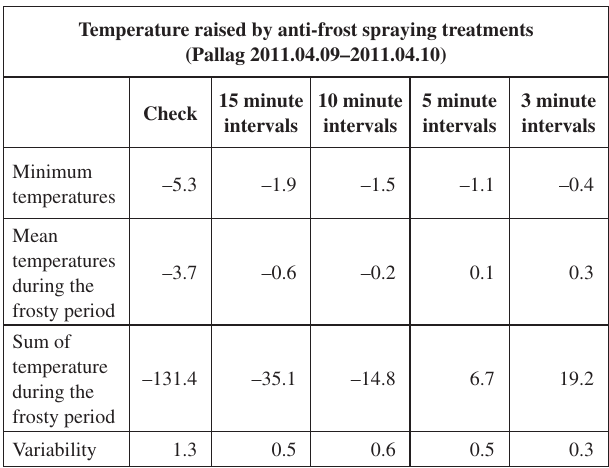
-10,0-5,00,05,010,015,020,0 Figure 8 – Temperatures as changing in the spraying experiment with 5 minute intervals (blue) related to the check area (red) in the plum plantation at Pallag between April 9. 09.00 and 10. 09.00, 2012.